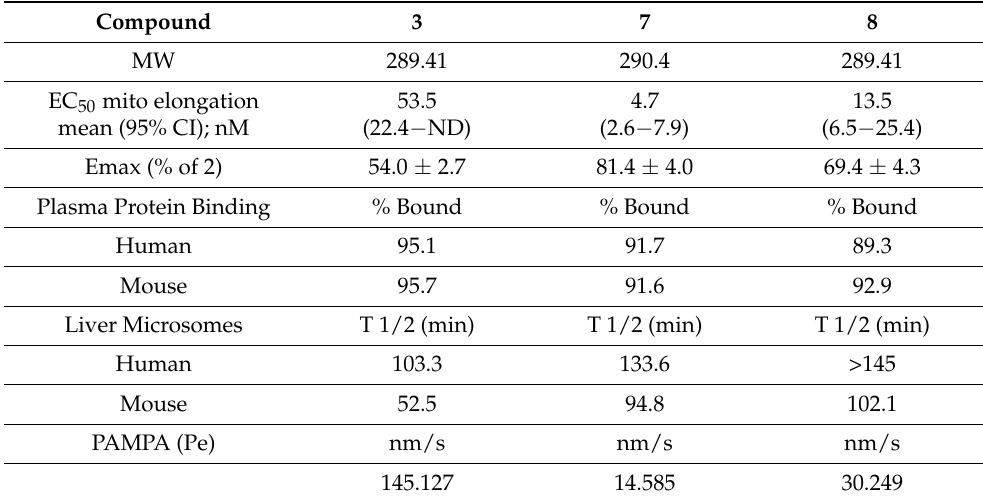
Table 3. Functional and pharmacokinetic properties of amide variants of 3 . Values for 3 are duplicated from Table 2 for comparison.